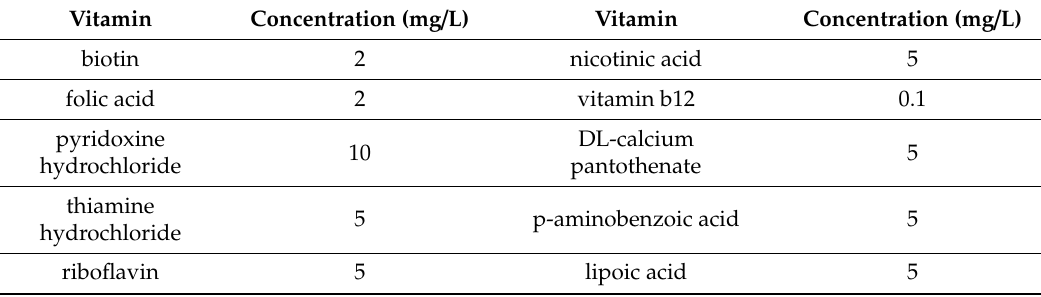
Table 2. Formulation of vitamin solution.